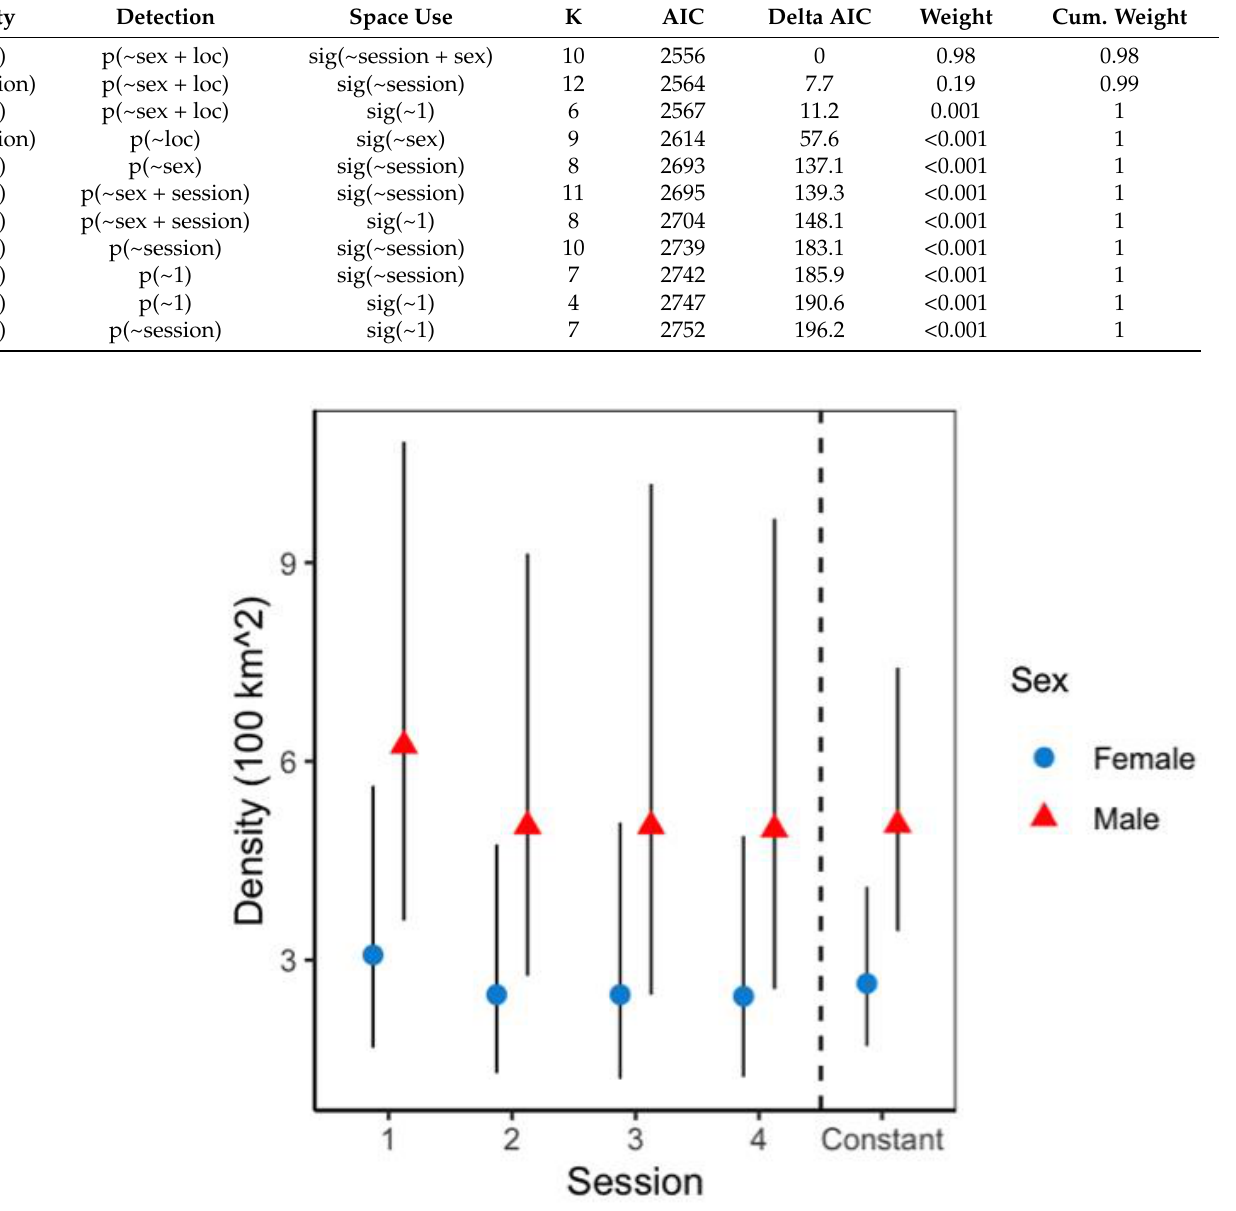
Figure 4. Sex/session specific jaguar density, from top model structure in Sector Santa Rosa, Guana- caste Conservation Area, Northwestern Costa Rica. The black line represents 95% confidence inter- vals.